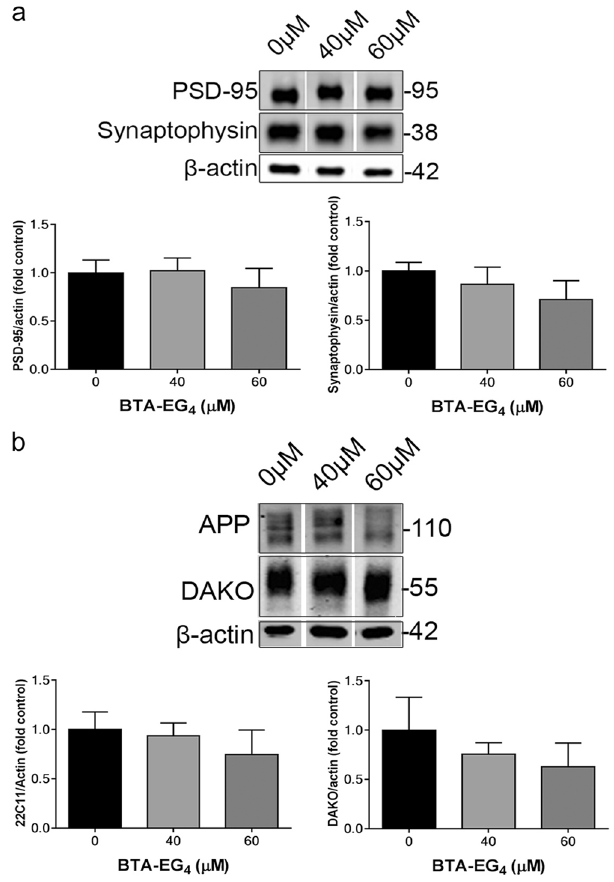
Figure 5. Levels of synaptic markers and synaptic APP and tau are unaltered following BTA-EG 4 treatment. Representative western blots of synaptosome fractions isolated following 48 h 40–60 μ M BTA-EG 4 and control (DMSO, 0 μ M) treatment of 3xTg-AD slice cultures. Blots are probed with antibodies against ( a ) synaptophysin and PSD-95 and ( b ) N-terminal APP (22C11) and total tau (phosphorylated and non-phosphorylated; DAKO). Blots were also probed with an antibody against β -actin as a loading control. Bar charts show amounts of ( a ) PSD-95 or synaptophysin, and ( b ) N-terminal APP (22C11) or tau (DAKO) relative to β -actin levels in each sample. n = 5–10. Data is mean ± SEM shown as fold change from control. All data analysed by one-way ANOVA, with post-hoc Dunnett’s multiple comparisons